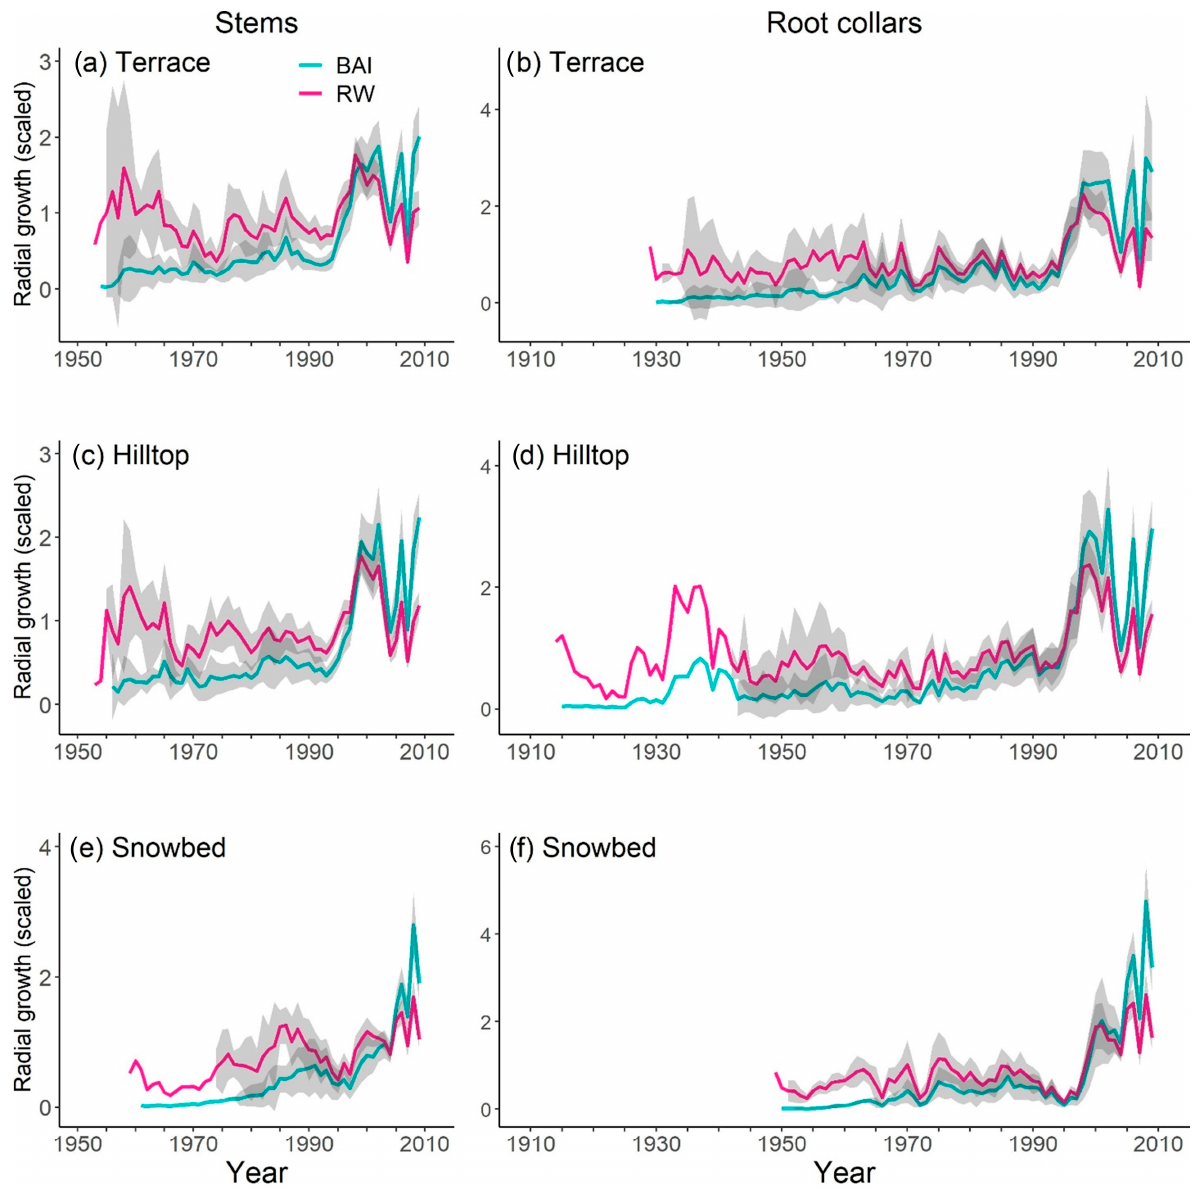
Figure 4. Mean growth chronologies of the stems ( a , c , e ) and root collars ( b , d , f ) using mean ‐ centered ring width (RW; pink) and calculated basal area increment (BAI; blue). Shaded areas represent 95% confidence intervals.